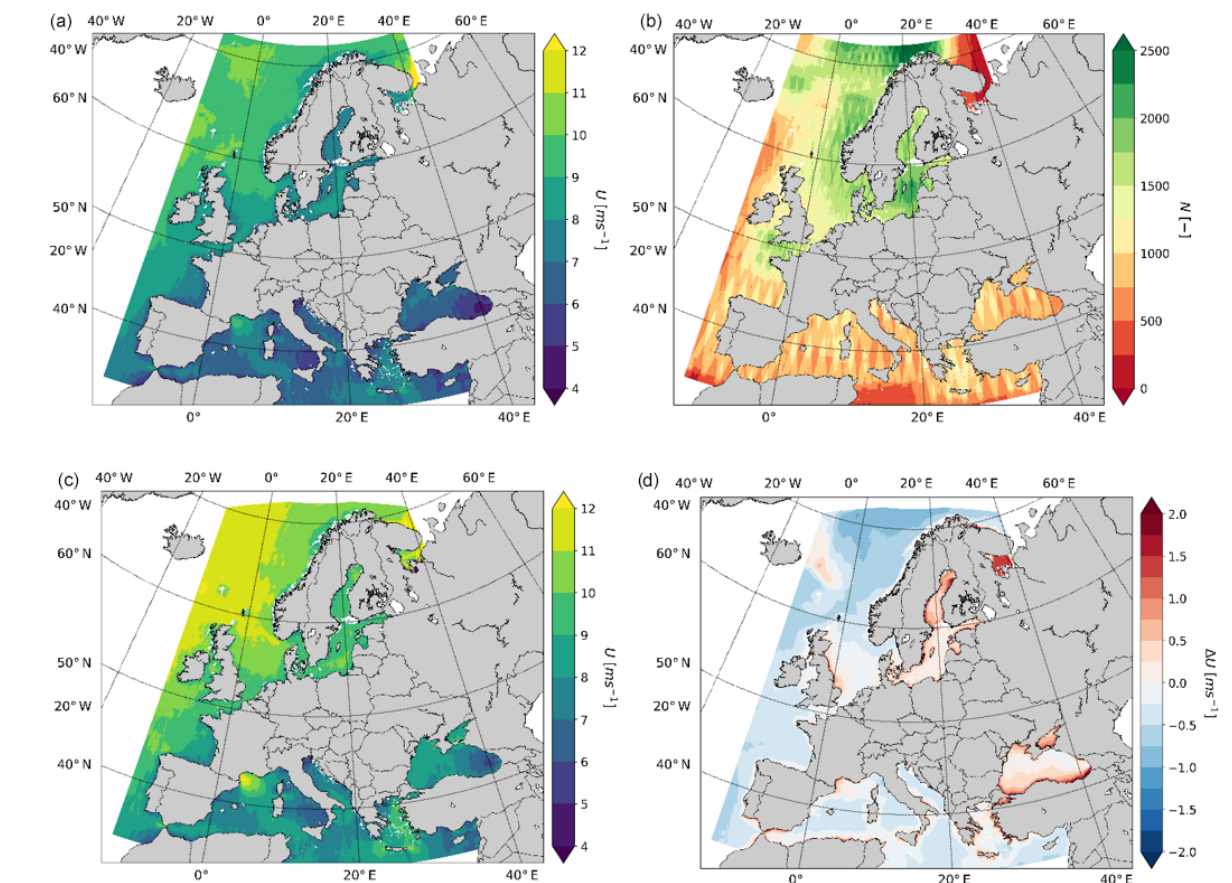
Figure 3. For Envisat ASAR and Sentinel-1 combined mean wind speed (ms − 1 ) at 10m height (a) , number of samples (b) , mean wind speed at 100ma.m.s.l. including long-term stability correction for extrapolation (c) and difference on wind speed at 100ma.m.s.l. height based on long-term stability correction minus neutral wind profile assumption (d) are